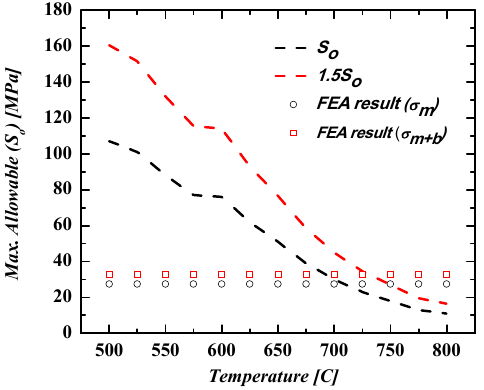
Figure 10. Maximum allowable misalignment (% of initial channel’s width) under various temperature conditions.